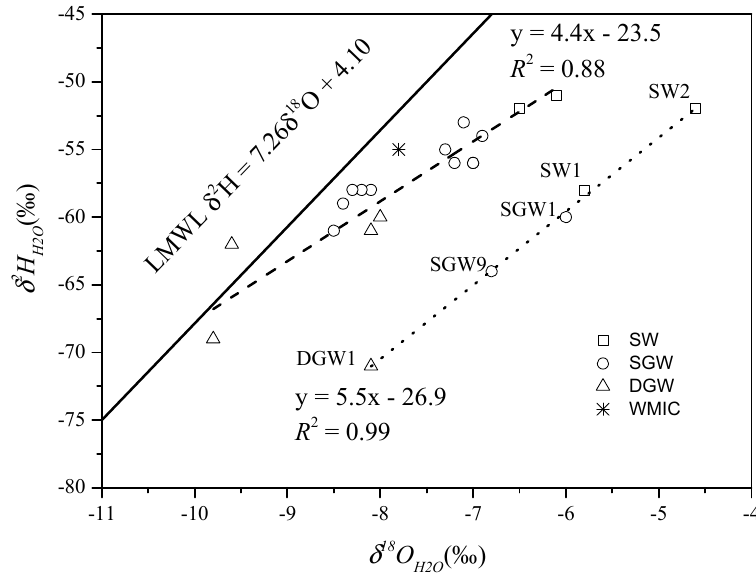
Figure 6. Plot of δ 2 H against δ 18 O H2O for surface and ground water samples from the Shijiazhuang area. Local meteoric water line (LMWL, solid line) and evaporation lines (dashed line and dotted line) are shown for comparison. The LMWL is defined by Jia et al . [45]. (SW: Surface water; SGW: Shallow groundwater; DGW: Deep groundwater; WMIC: Weighted mean isotope